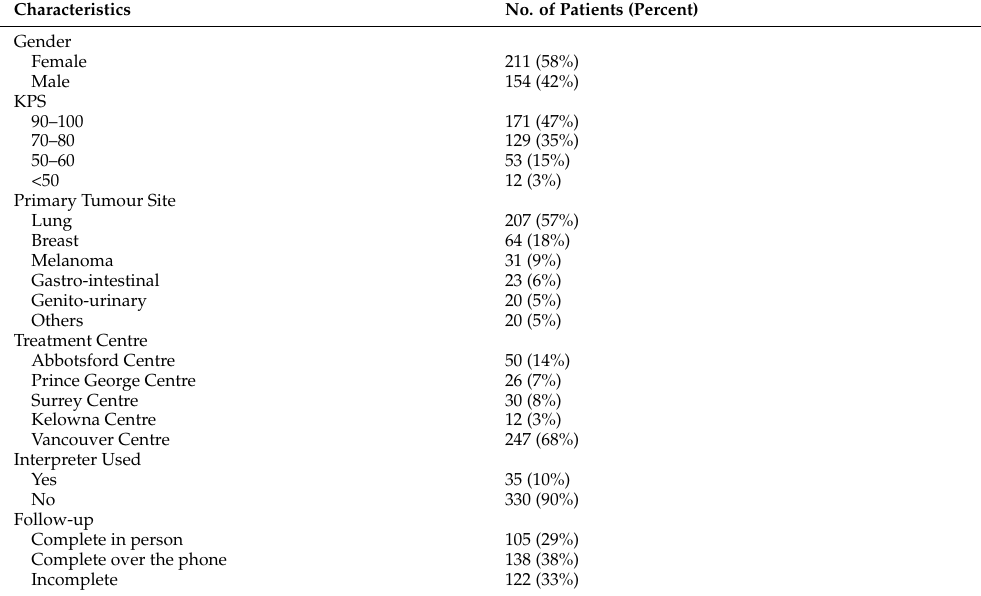
Table 1. Characteristics of patient